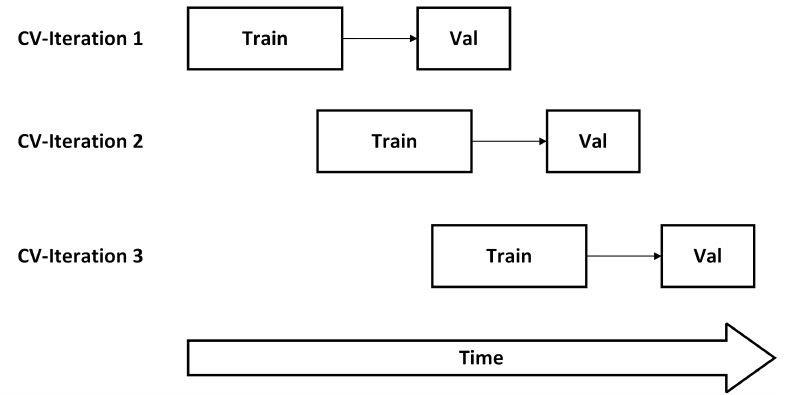
Figure 4. Sliding Window with dedicated cutoff points